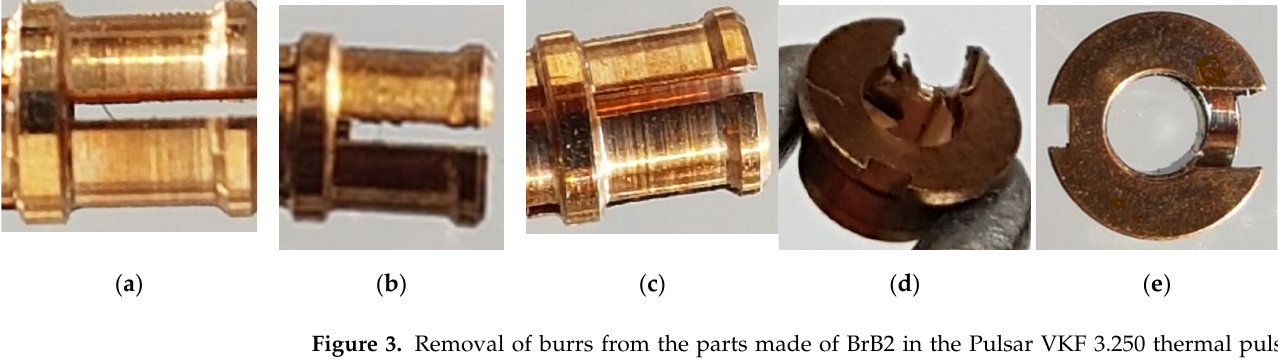
6 of 17 Figure 2. Change in the nature of burrs on parts made of beryllium bronze: ( a ) processing with the parameters recommended by the tool manufacturer (upper values); ( b ) processing the experimen- tally selected parameters.